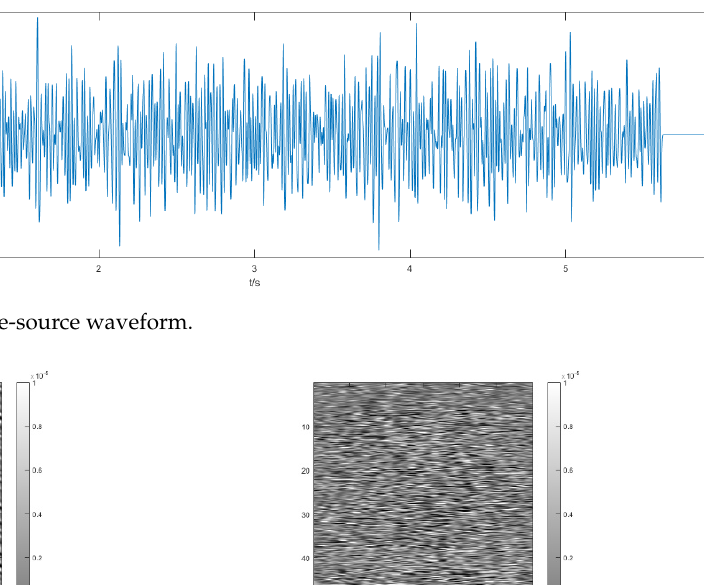
Figure 2. Random passive ‐ source waveform.